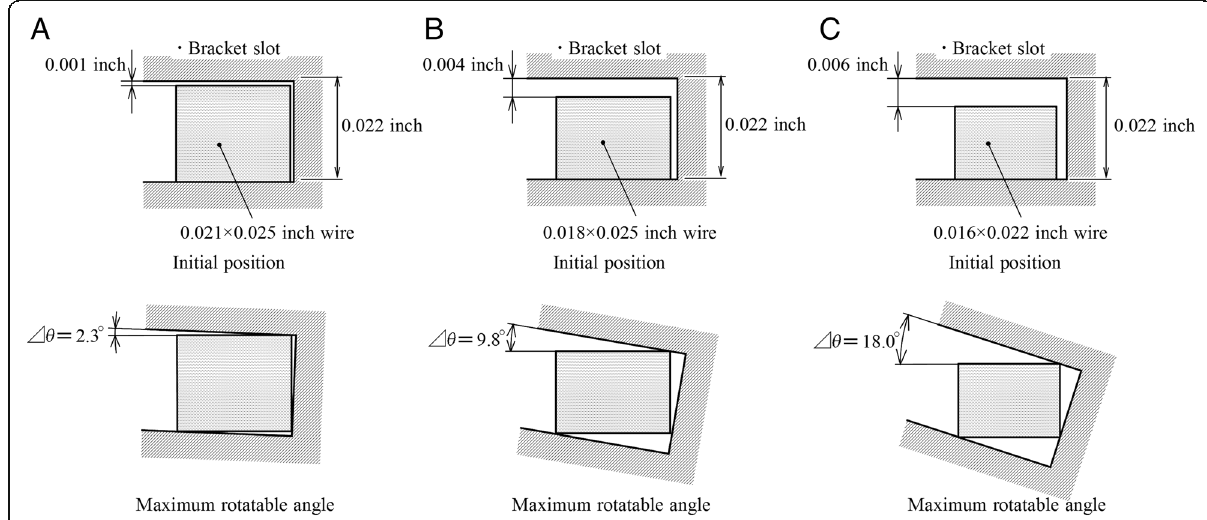
Fig. 1 Initial positions and maximum rotation angles, Δθ , when archwires of 0.021, 0.018, and 0.016 in. are inserted into a bracket of 0.022 in.. a 0.021 in. b 0.018 in. c 0.016